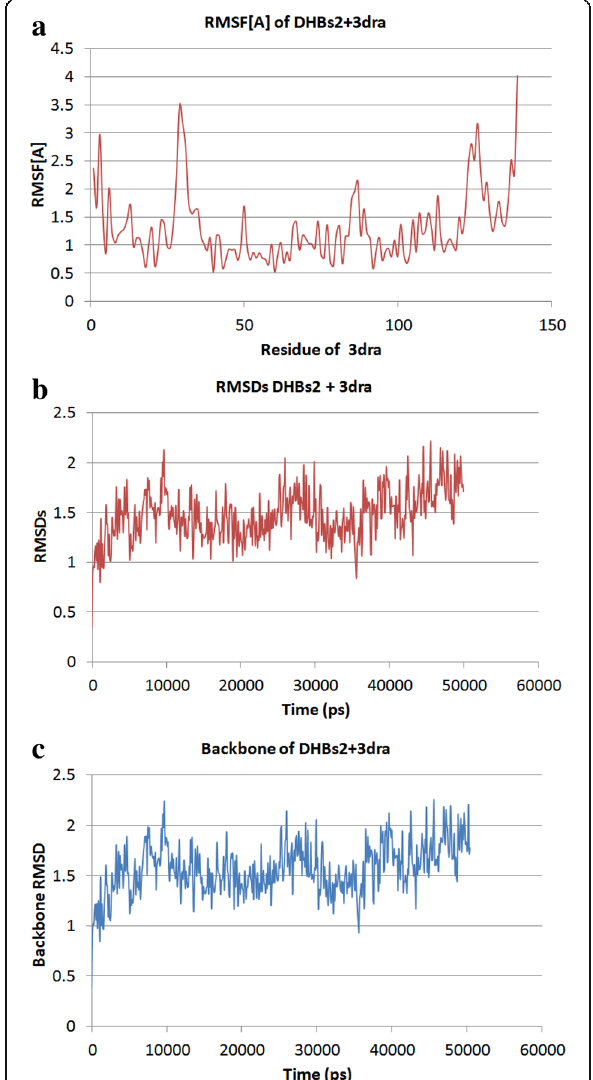
Fig. 4 Analysis of 50ns RMSD, RMSF, and Backbone of selected three complexes with protein at 50 ns MD simulations. a RMSD of the 3dra. b RMSF (Å) of 3dra. c Backbone of the